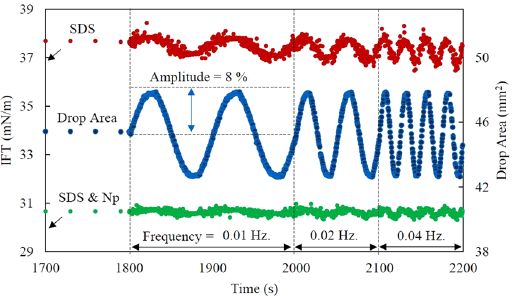
Figure 2. IFT variations during sinusoidal drop oscillation for an SDS solution (0.05 CMC) without (upper curve) and with (lower curve) 1.0 wt.% nanoparticle (Levasil 300/30, 9 nm). The middle curve shows drop surface area variations during